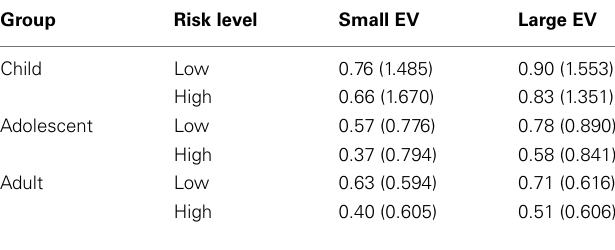
Table 1 | Behavioral data: probability of selecting a gamble over a sure bet (RT in